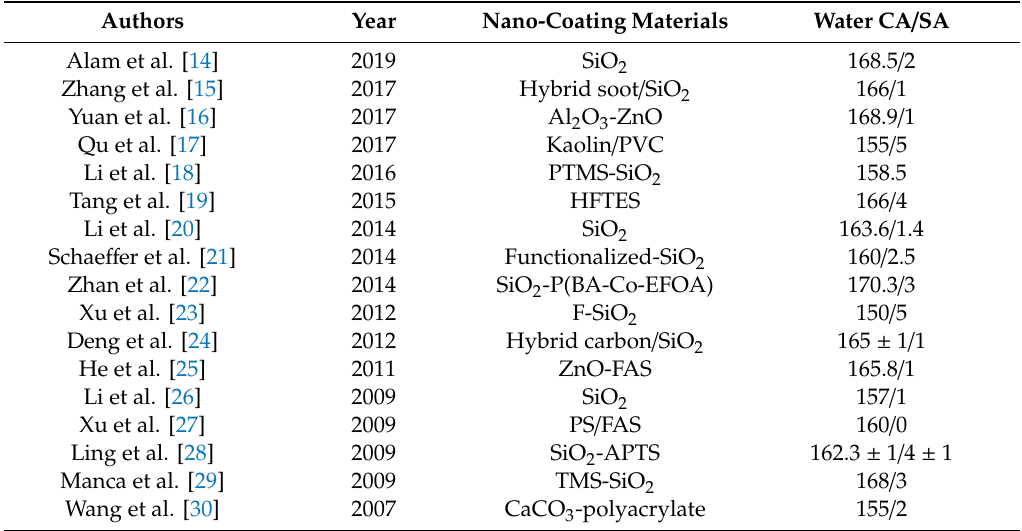
Table 1. Summary of a literature review of self-cleaning strategies.